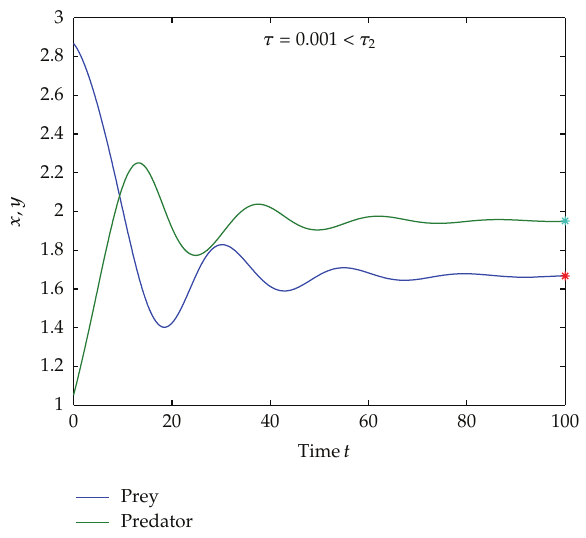
Figure 3: The equilibrium E is asymptotically stable when τ (cid:6) 0 .